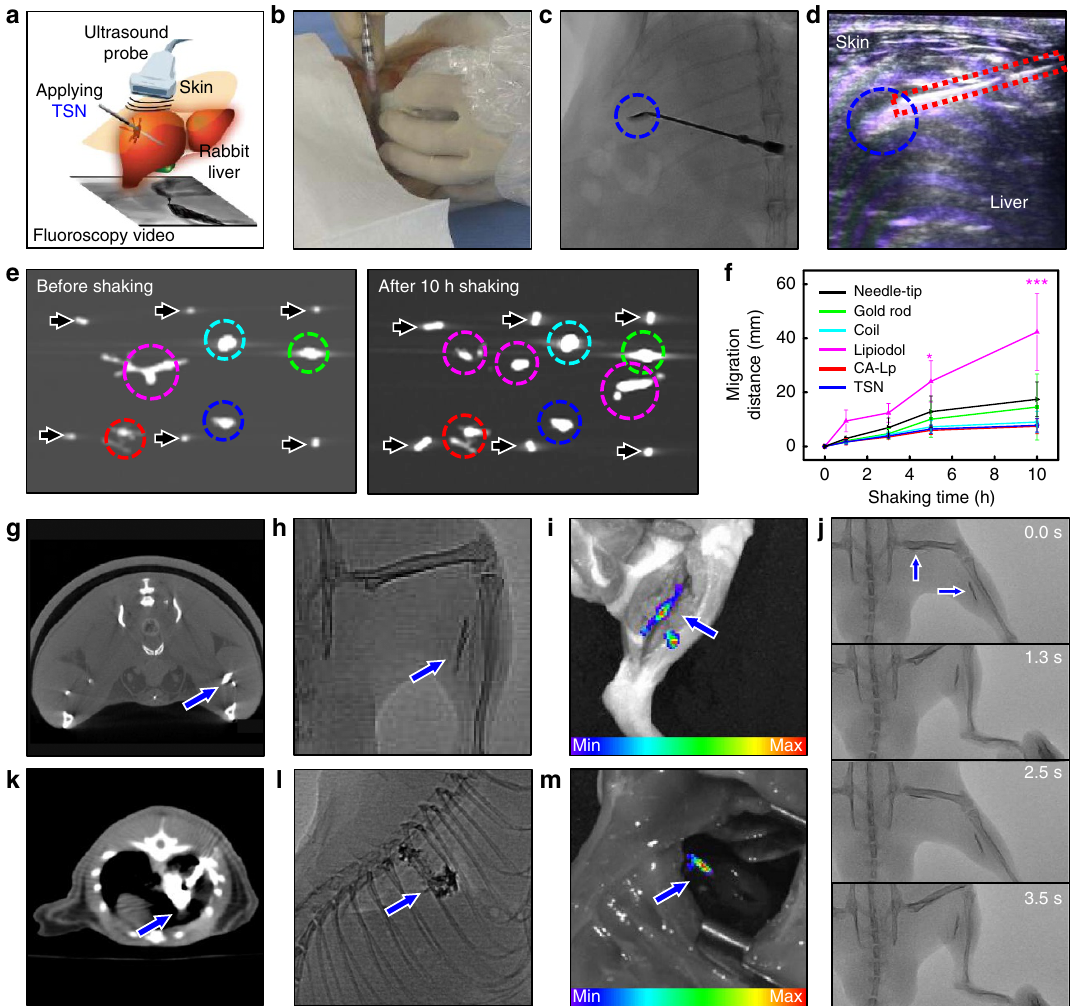
Figure 5 | In vivo applications of TSNs in multimodal image-guided procedures. ( a – d ) TSN adhesive for an incision-free surgical procedure in a rabbit liver puncture model, assisted by simultaneous real-time fluoroscopy and ultrasonography. ( a ) Schematic drawing of the minimally invasive procedures that consist of puncture and closing under two real-time imaging modalities. ( b ) The incision-free image-guided procedure. A photograph showing the sealing process of a liver puncture track by injecting TSNs contained in a syringe. Still images of fluoroscopic video ( c ) and ultrasonography ( d ) during the track sealing with TSNs. Blue dashed circles and red dashed rectangle indicate TSN adhesive and needles, respectively. ( e , f ) Mobility evaluation of fiducial markers. ( e ) Top view CT images of the implanted markers before and after 10h shaking. Black arrows indicate needle tips, and dashed circles indicate the markers, TSNs (blue), gold rod (green), metal coil (cyan), Lipiodol (magenta), and CA-Lp (red) in the liver. ( f ) Average migration distances of the markers in the liver. (Data are shown as mean ± s.d. n ¼ 3, * P o 0.05, *** P o 0.001 compared to needle-tip, two-way ANOVA test.) ( g – j ) Multimodal imaging of the TSNs as an injectable fiducial marker implanted to the calf muscles of a SD rat. ( g ) Transversal micro-CT image showing the location of TSNs near the fibula (calf bone). ( h ) Fluoroscopic image of the implanted TSNs along with the fibula. ( i ) Fluorescent weighted image of the same region. ( j ) A series of still cuts of fluoroscopic video showing that TSN markers follow during extension and flexion movement of leg. (Blue arrows indicate the TSN markers, and the numbers on figure ( j ) represent the time of each frame.) ( k – m ) Multimodal imaging of the percutaneously injectable TSN marker in rat lung cancer. ( k ) Axial image of CT. ( l ) Lateral view on fluoroscopy. ( m ) Fluorescence imaging after thoracostomy (Blue arrows indicate the TSNs marked in lung